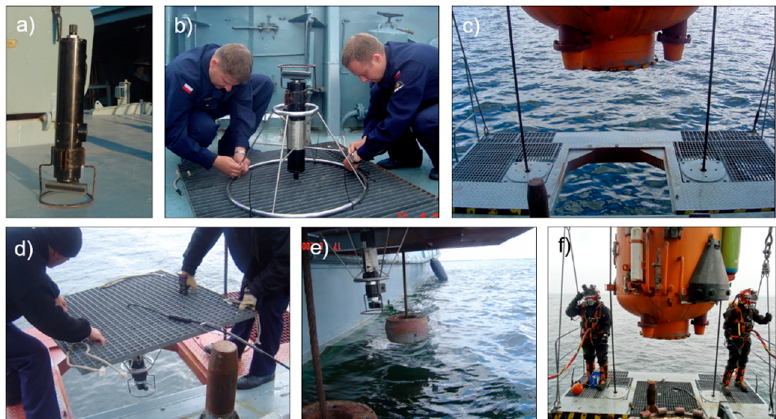
Figure 9. The preparation steps of a scanning sonar for use on a diving platform: ( a ) scanning sonar; ( b ) mounting sonar to the mount and truss; ( c ) a diving platform with a diving bell on the rescue ship; ( d ) mounting a grate with the sonar to the diving platform; ( e ) stabilizing anchors with a sonar attached to the diving platform; ( f ) a sonar system and pair of divers prior to lowering to the aircraft carrier wreck.